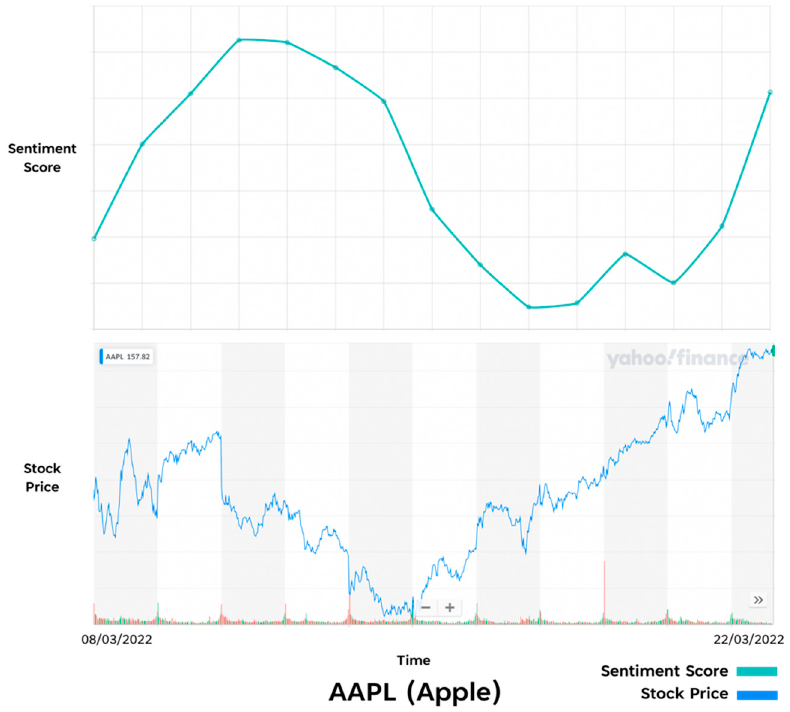
Figure 19. Comparison of Prototype results and Real-Life results—META.